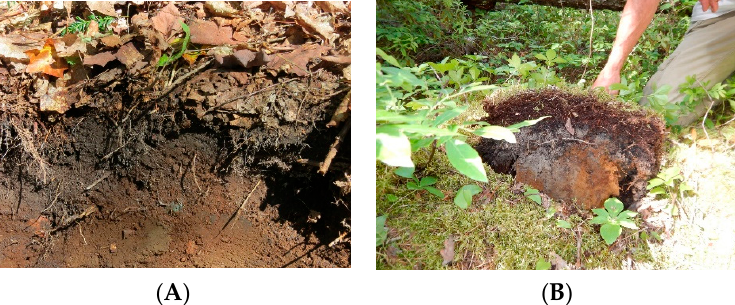
Figure 2. Example ( A ) hardwood and ( B ) softwood profiles showing forest floor and upper mineral soil morphologies of soil resampling sites in Eastern Canada and the Northeastern United States.